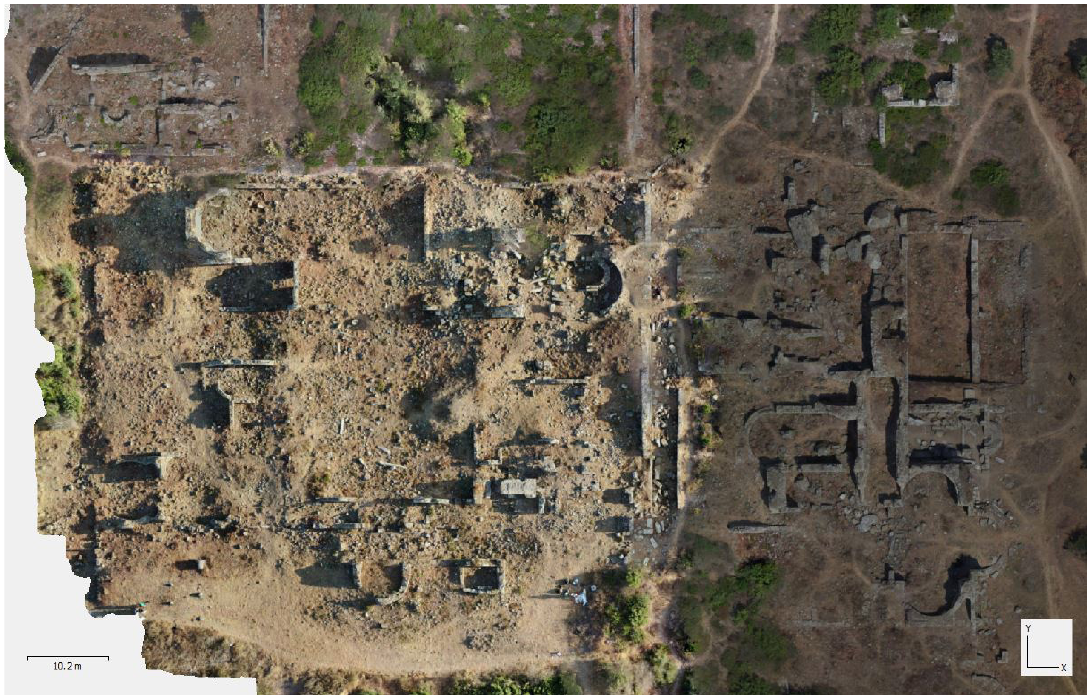
Figure 10. 2016 and 2018 field campaigns survey orthomosaic generated in Agisoft Photoscan 1.4.4 © ÖAW/IKAnt (M. Hernán- dez Cordero).